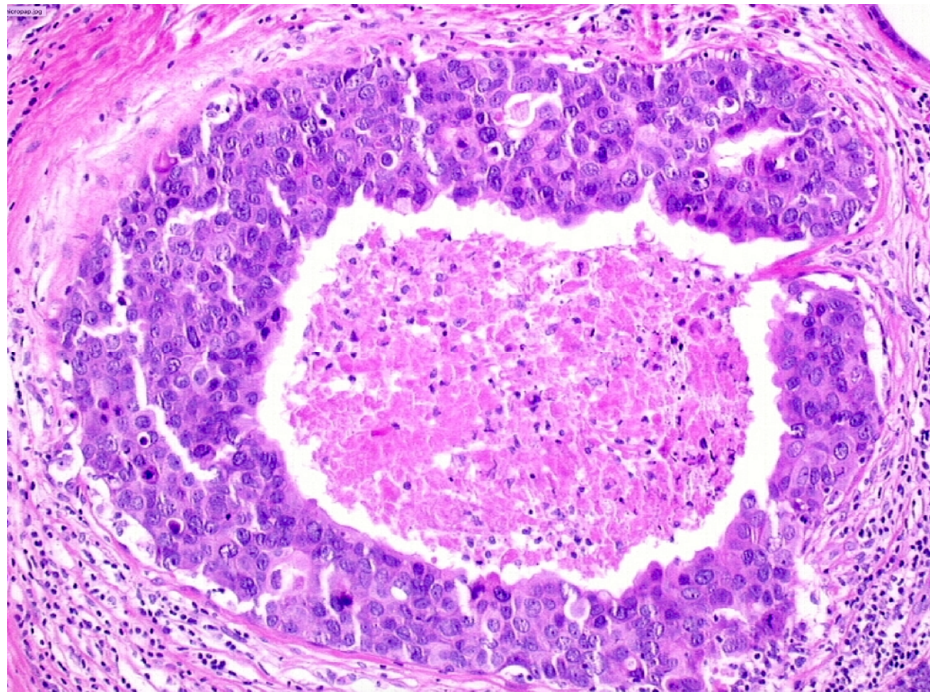
Figure 4. Ductal carcinoma in situ of high nuclear grade with central necrosis